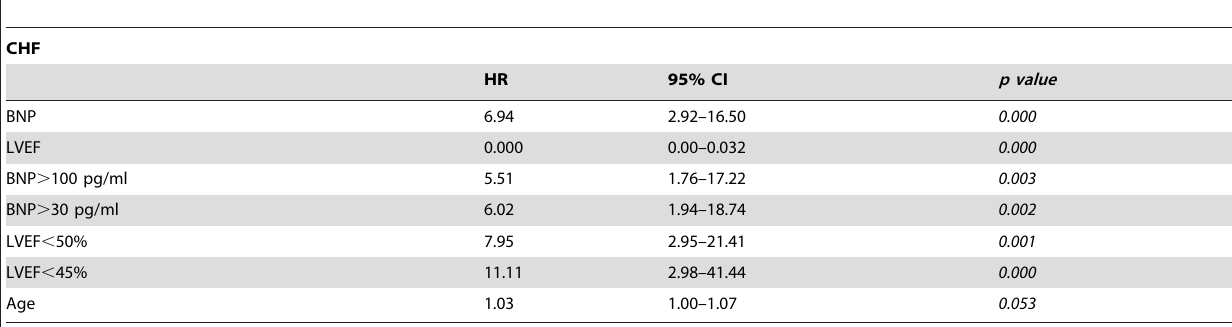
Table 4. Univariate Cox regression analysis for predicting hospitalization for congestive heart failure in relation to selected cut-off values of BNP concentration and